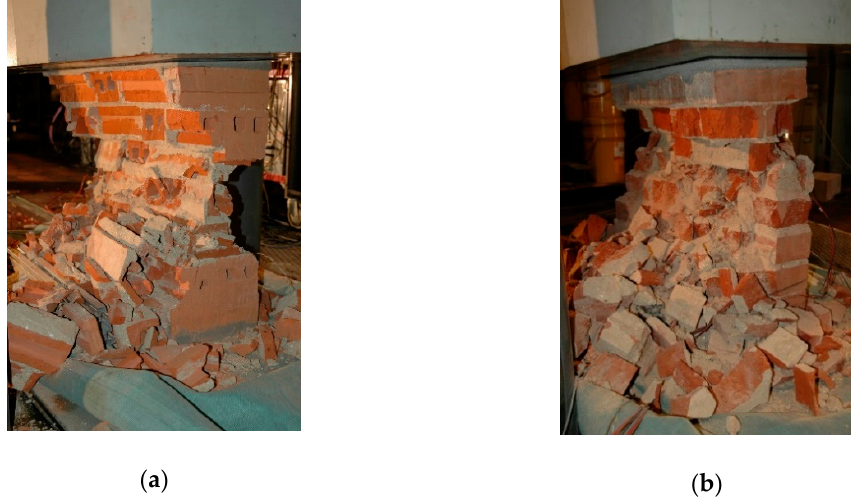
Figure 10. Collapse mechanism resulting from compression tests: ( a ) ceramic hollow brick specimen; ( b ) ceramic solid brick specimen.